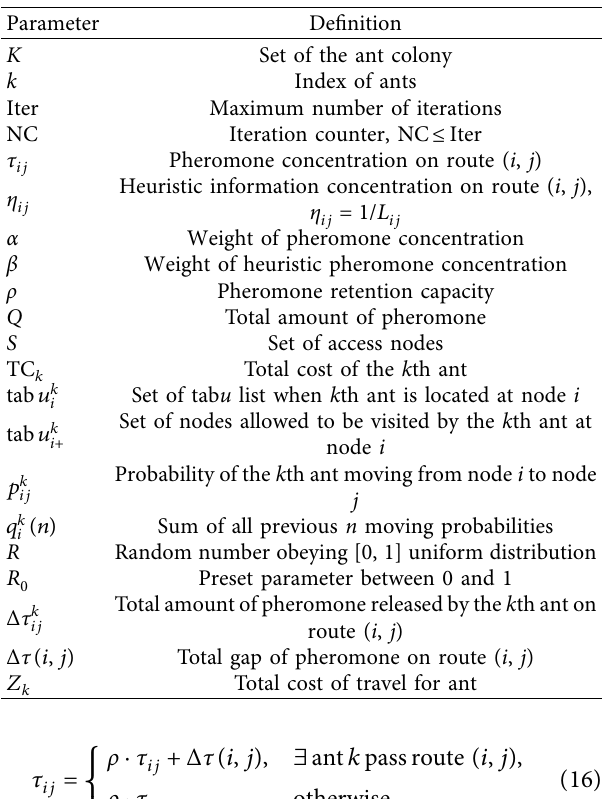
Table 2: The sets, indices, and parameters used for solving the TPOM-EI.